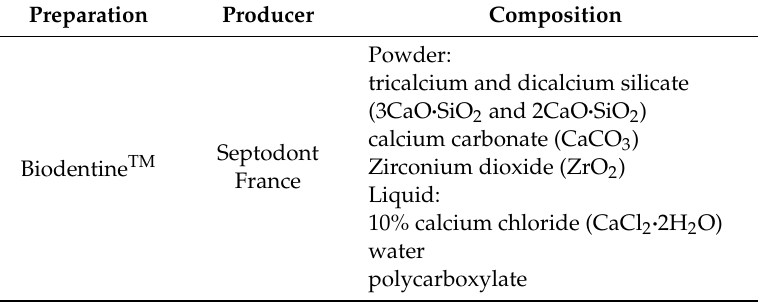
Table 1. Detailed manufacturer data on the Biodentine TM used for